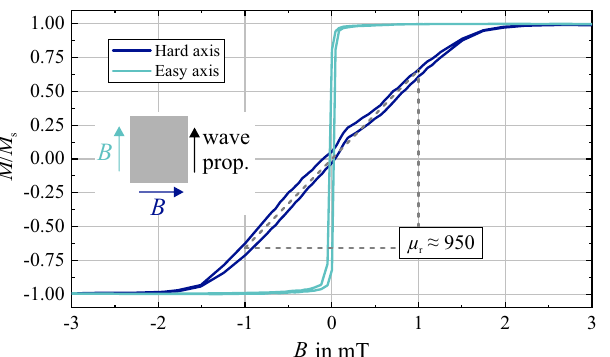
Figure 2. Magnetization loops along (easy axis) and perpendicular (hard axis) to the direction of wave propagation of the SAW device measured by magnetooptical magnetometry. The relative permeability perpendicular to the direction of wave propagation is around µ r ≈ 950. The magnetic film geometry and the measurement directions are